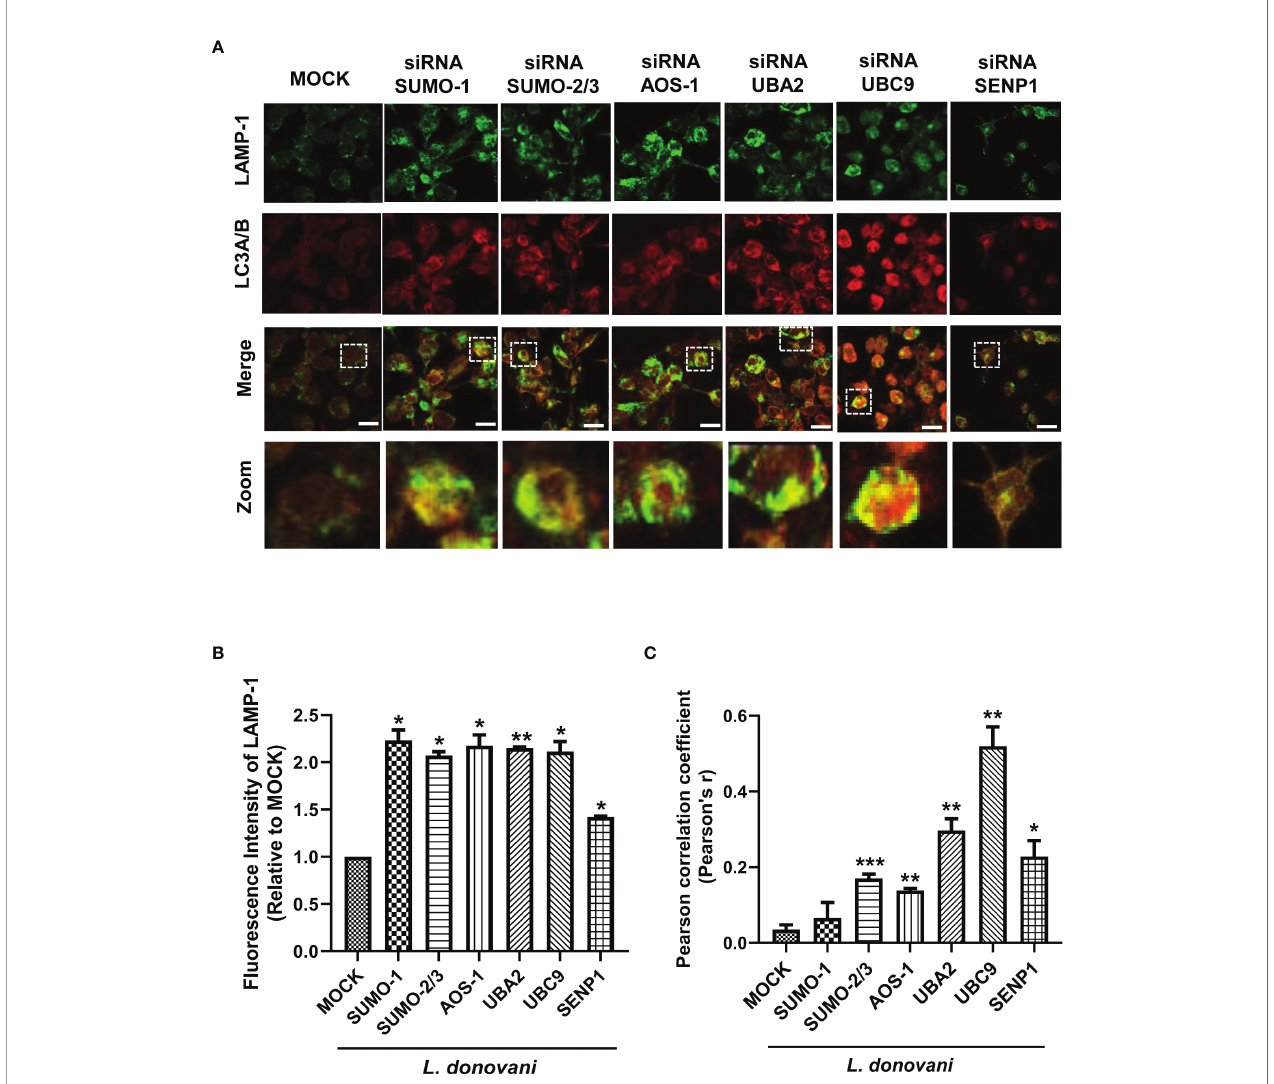
FIGURE 4 | Host SUMOylation favors the growth of Leishmania donovani by modulating autophagy maturation. Colocalization studies of autophagosome marker, LC3A/B, and lysosome marker, LAMP-1, in L. donovani -infected macrophages were performed. (A) 0.5 × 10 6 THP-1 macrophages were transfected with speci fi c siRNAs followed by the infection of 20 MOI of L. donovani for 24 h MOCK here represents the transfection with a control siRNA. Macrophages were incubated with the antibodies to LAMP-1 and LC3A/B with their respective secondary antibodies (see the Materials and Methods section). Images were acquired under confocal microscopy. Here, the green color represents the expression level of LAMP-1, the red color represents the expression level of LC3A/B, and the yellow color represents the colocalization of LAMP-1 and LC3A/B. Scale bar, 10 µm. A ×5 zoom image represents colocalization in a single cell. (B) The graph represents the fl uorescence intensity measurement of LAMP-1. Statistical signi fi cance was quanti fi ed using the unpaired t-test with Welch ’ s correction, * p = 0.04, 0.017, 0.044, 0.043, and 0.011 for MOCK vs. SUMO-1 , SUMO-2/3 , AOS-1 , UBC9 , and SENP1 , respectively; ** p = 0.004 for MOCK vs. UBA2 . (C) Graphical representation of colocalization measured by Pearson ’ s correlation coef fi cient; values range between − 1 and +1. A value of +1 indicates a positive and strong correlation, while a value of − 1 indicates a negative and weak correlation. Statistical signi fi cance was quanti fi ed using the unpaired t-test with Welch ’ s correction, * p = 0.011 for MOCK vs. SENP1 ; ** p = 0.0014, 0.0017, and 0.0024 for MOCK vs. AOS-1 , UBA2 , and UBC9 , respectively; *** p = 0.0002 for MOCK vs. SUMO-2/3 . MOI, multiplicity of